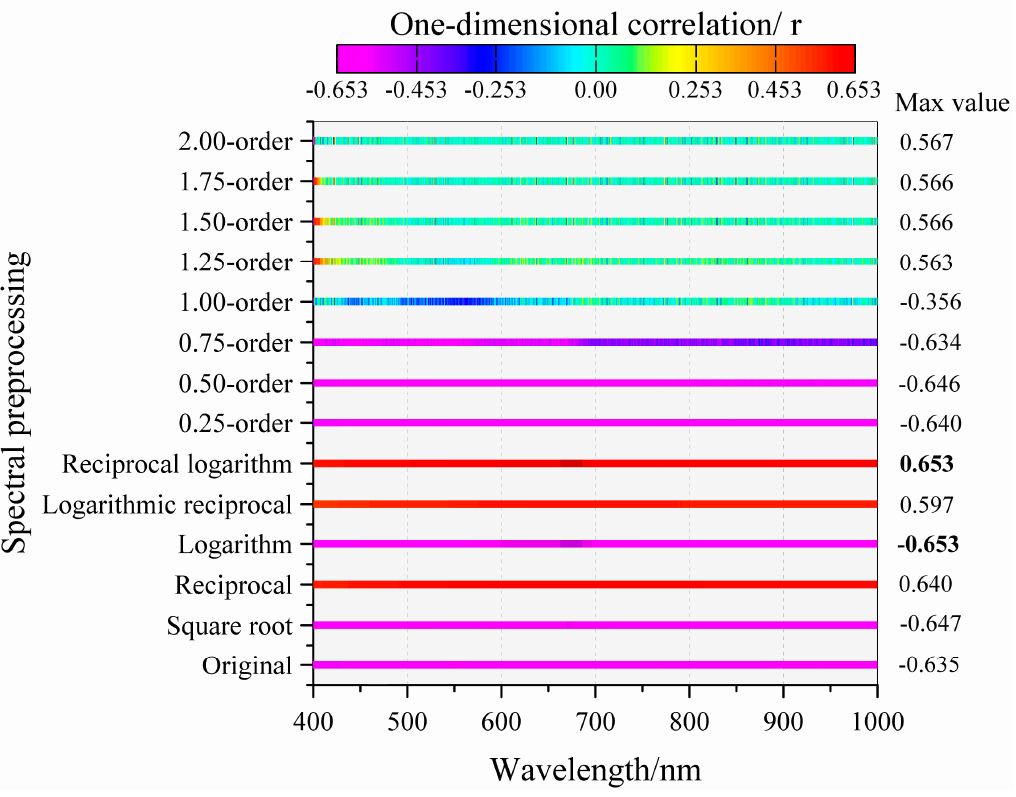
Figure 9. One-dimensional r diagram of SMC and transform spectrum.